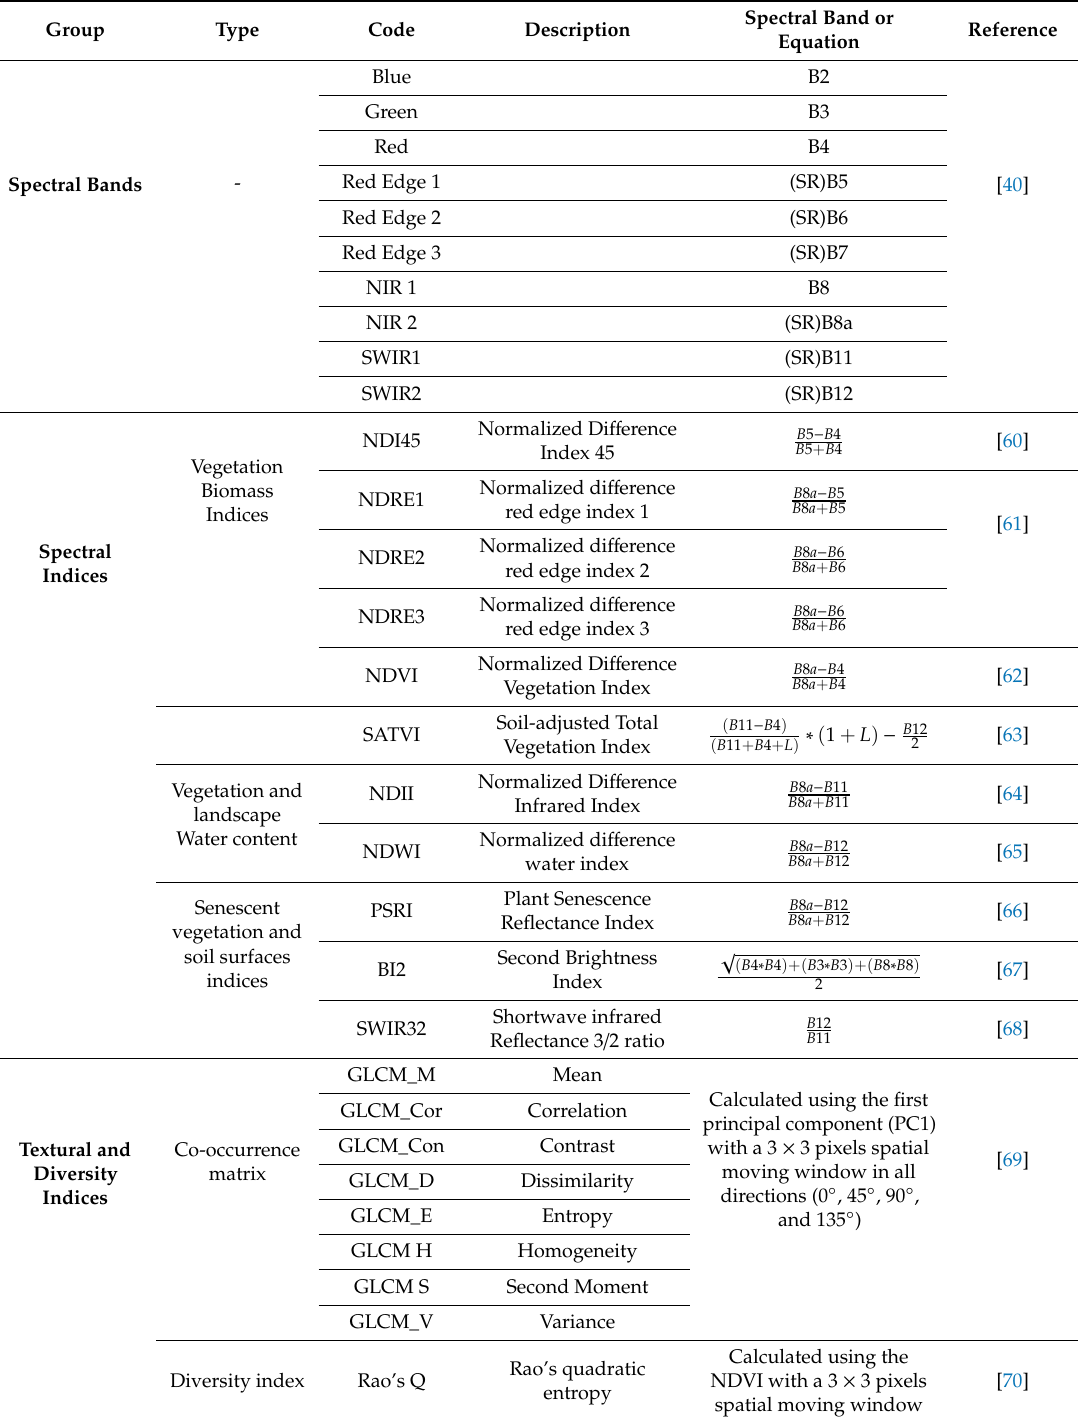
Table 1. Sentinel-2-derived predictors. The SR abbreviation indicates for which band was applied in the rescaling approach, namely for the Red edge 1, Red edge 2, Red edge 3, the NIR2, SWIR1, and SWIR2 (20m). L = 0.5 was applied in SATVI